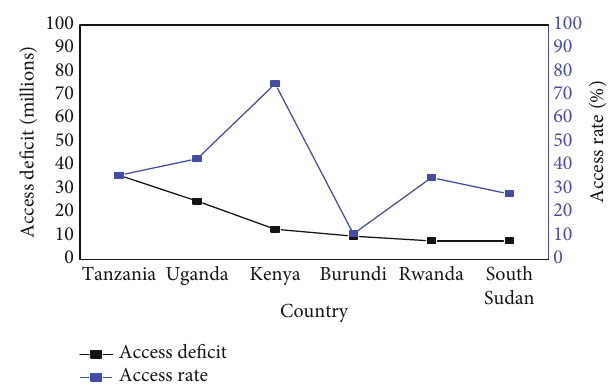
Figure 1: Access de fi cit population in millions and access rate